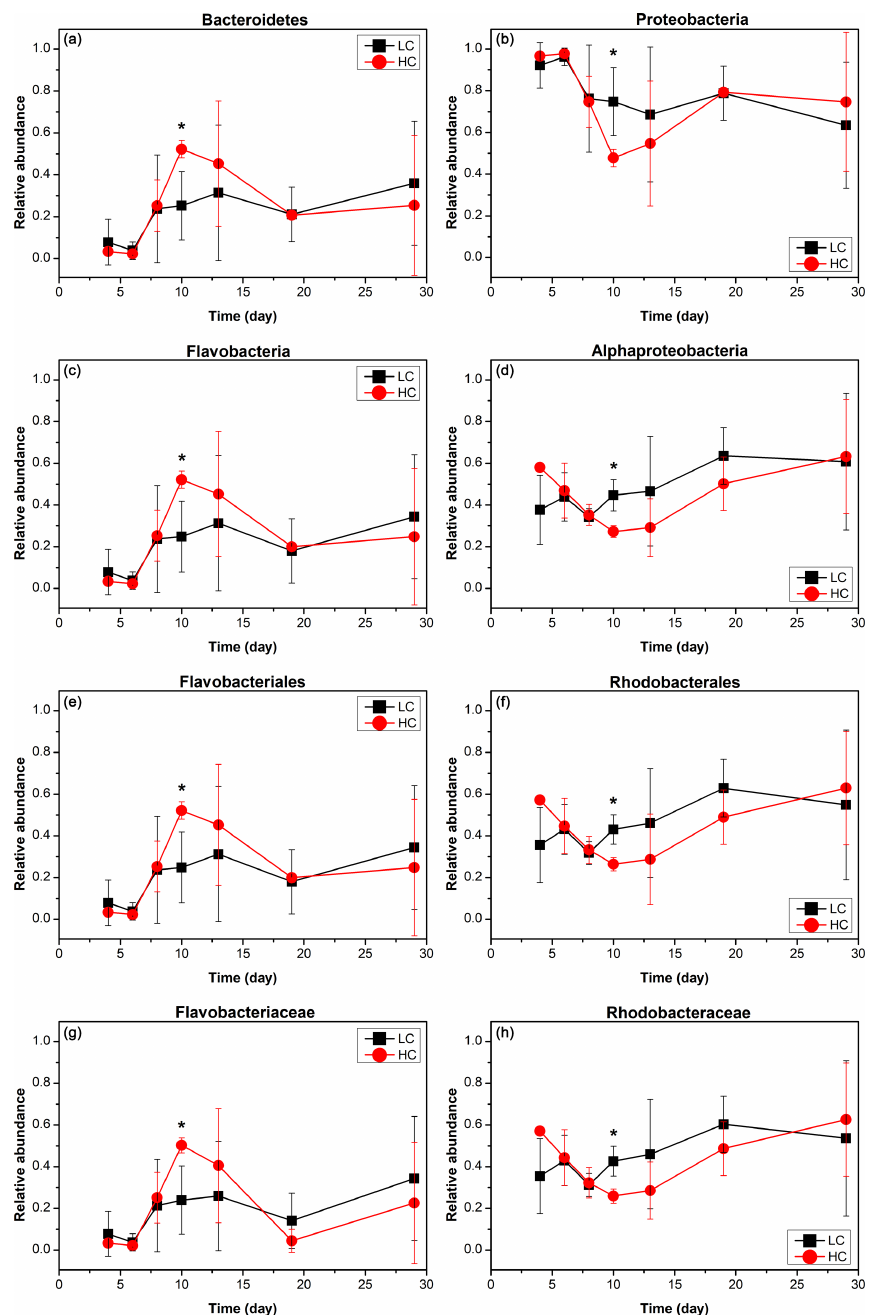
Figure 3. The relative abundance over time of primary taxa of the bacterioplankton community; HC in red and LC in black. Bacteroidetes (a) and Proteobacteria (b) are phylum level; Flavobacteria (c) and Alphaproteobacteria (d) are class level; Flavobacteriales (e) and Rhodobac- terales (f) are order level; Flavobacteriaceae (g) and Rhodobacteraceae (h) are family level. Data are the means ± SD ( n = 3), and the asterisk represents a difference at p